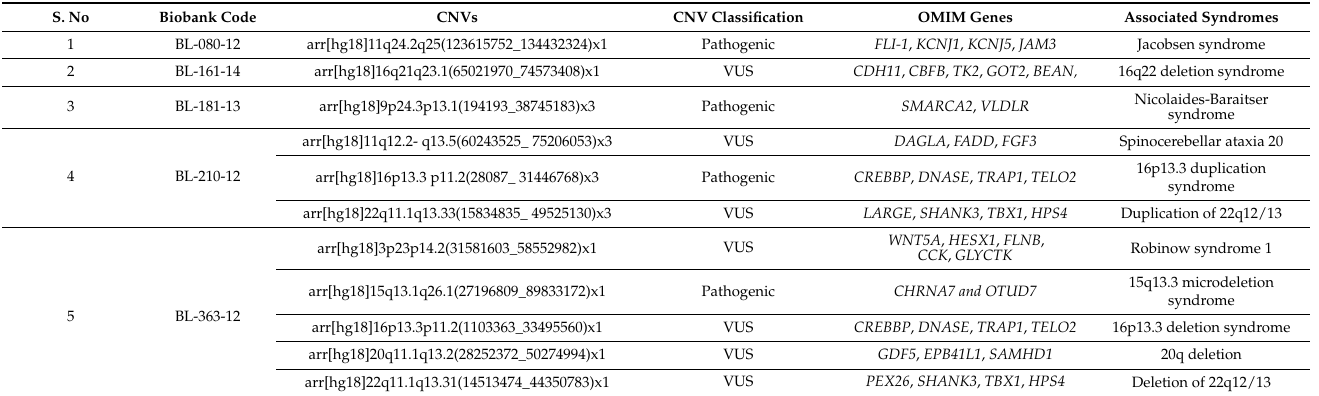
Table 2. Pathogenic and variants of uncertain significance and syndromic copy number variations detected by array CGH in pediatric developmental delay, congenital malformations, and intellectual disability